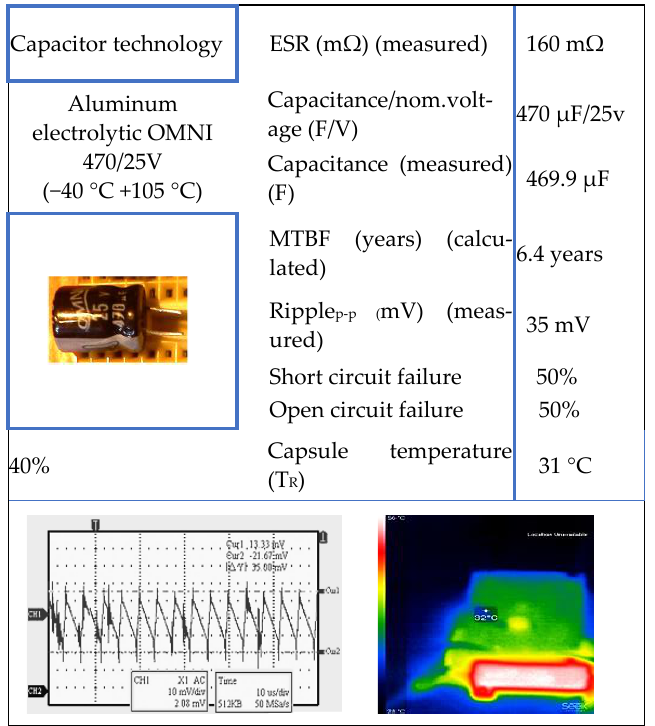
Figure 9. Data taken from measurement, photo of MLCC capacitor Murata, GRM32ER60J107ME20-type as DUT ( left–center ), the actual the ripple’s waveform ( left ) and surface capacitor’s temperature. (* Given that there is a variation in the capacity with DC-bias, i.e., its decrease, the parallel connection of three units leads to a better behavior compared to this aspect).